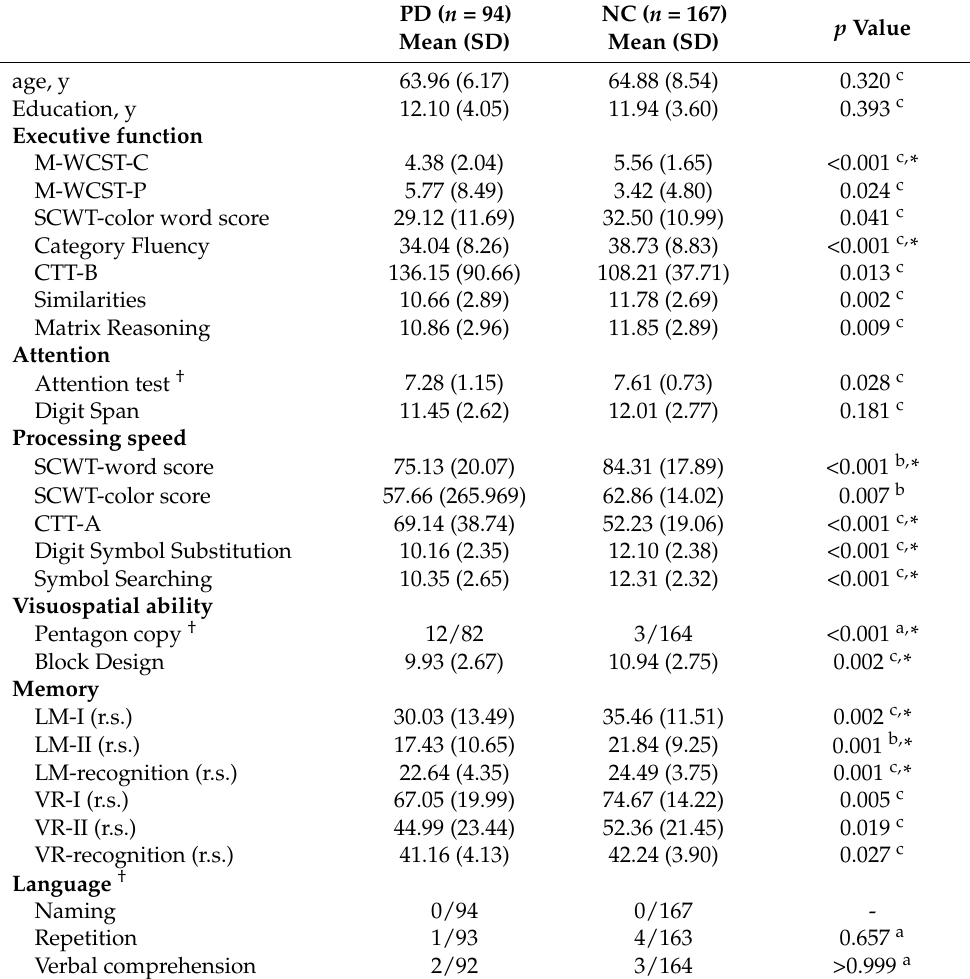
Table 2. The demographic data and neurocognitive function in study